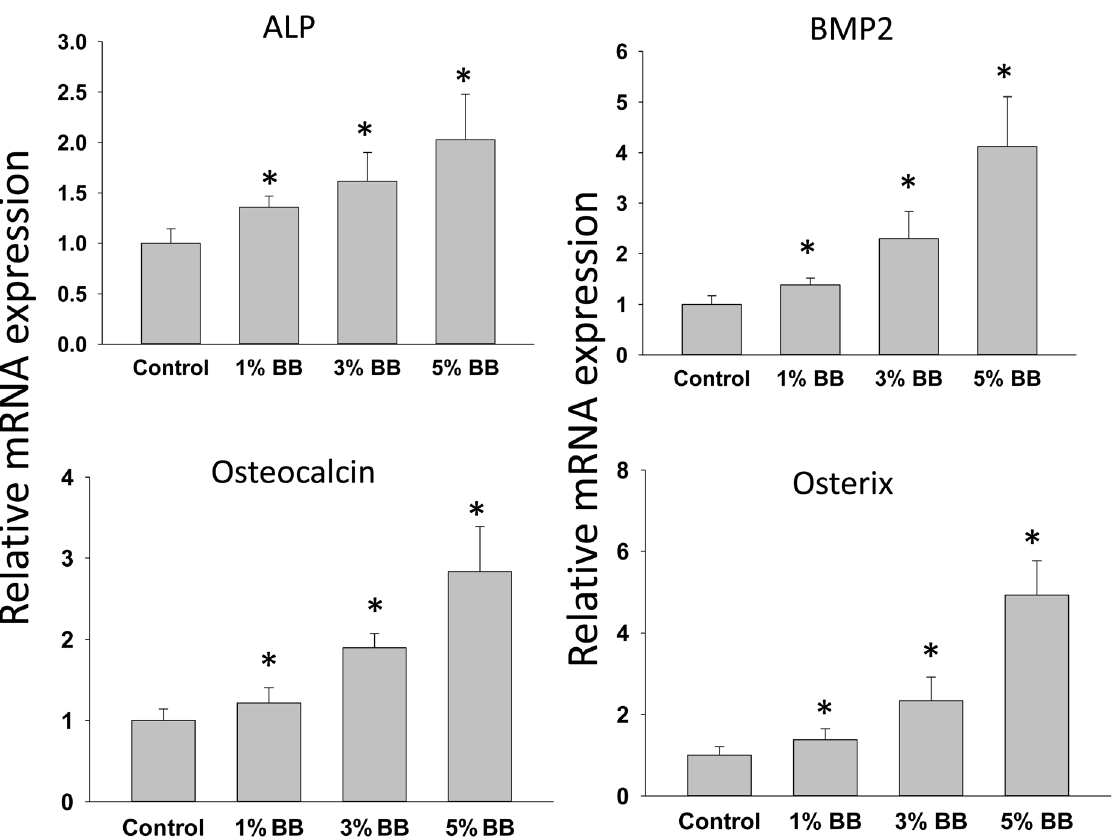
Figure 5. Gene expression of bone formation markers. Real-time PCR shows bone formation gene expression in bone from four different diet rat groups. ALP, alkaline phosphatase; BMP2, bone morphogenetic protein 2. Data are means 6 SEM. n=10 animals/group. *, p , 0.05 versus control.